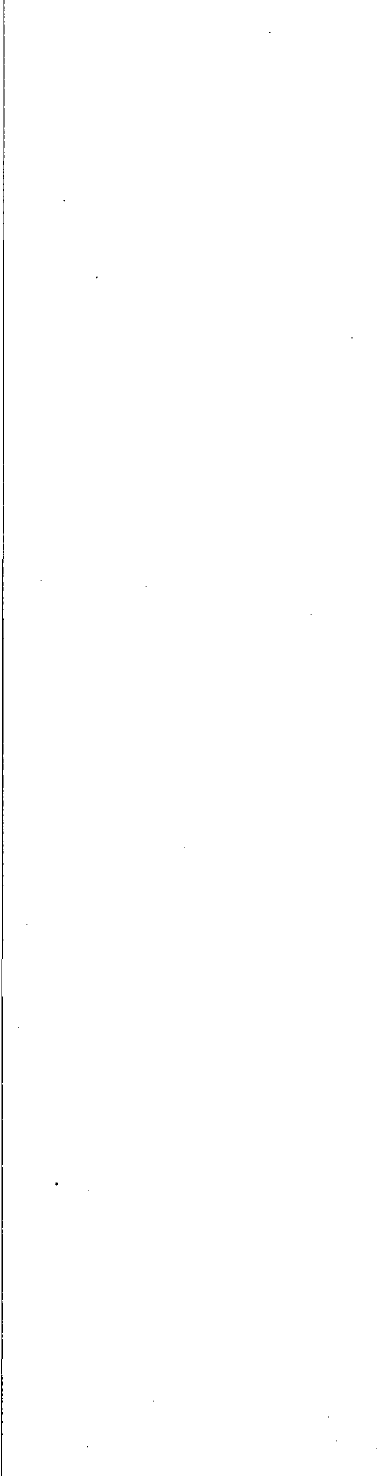
Figure 4a: Learning the theory by